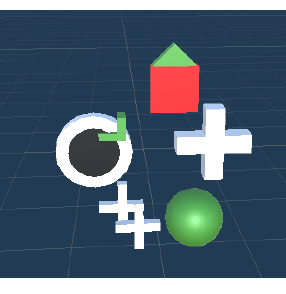
Figure 9. Automatic extraction of the data in the model projected on the hologram table.